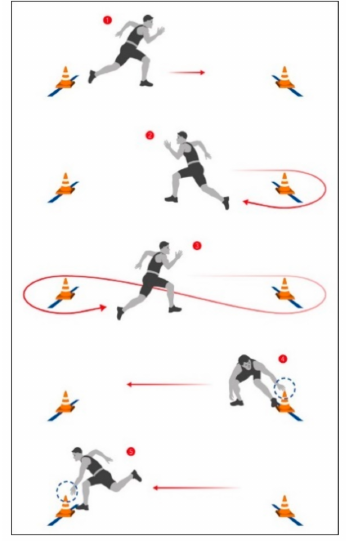
Figure 2. Four × 10 m shuttle